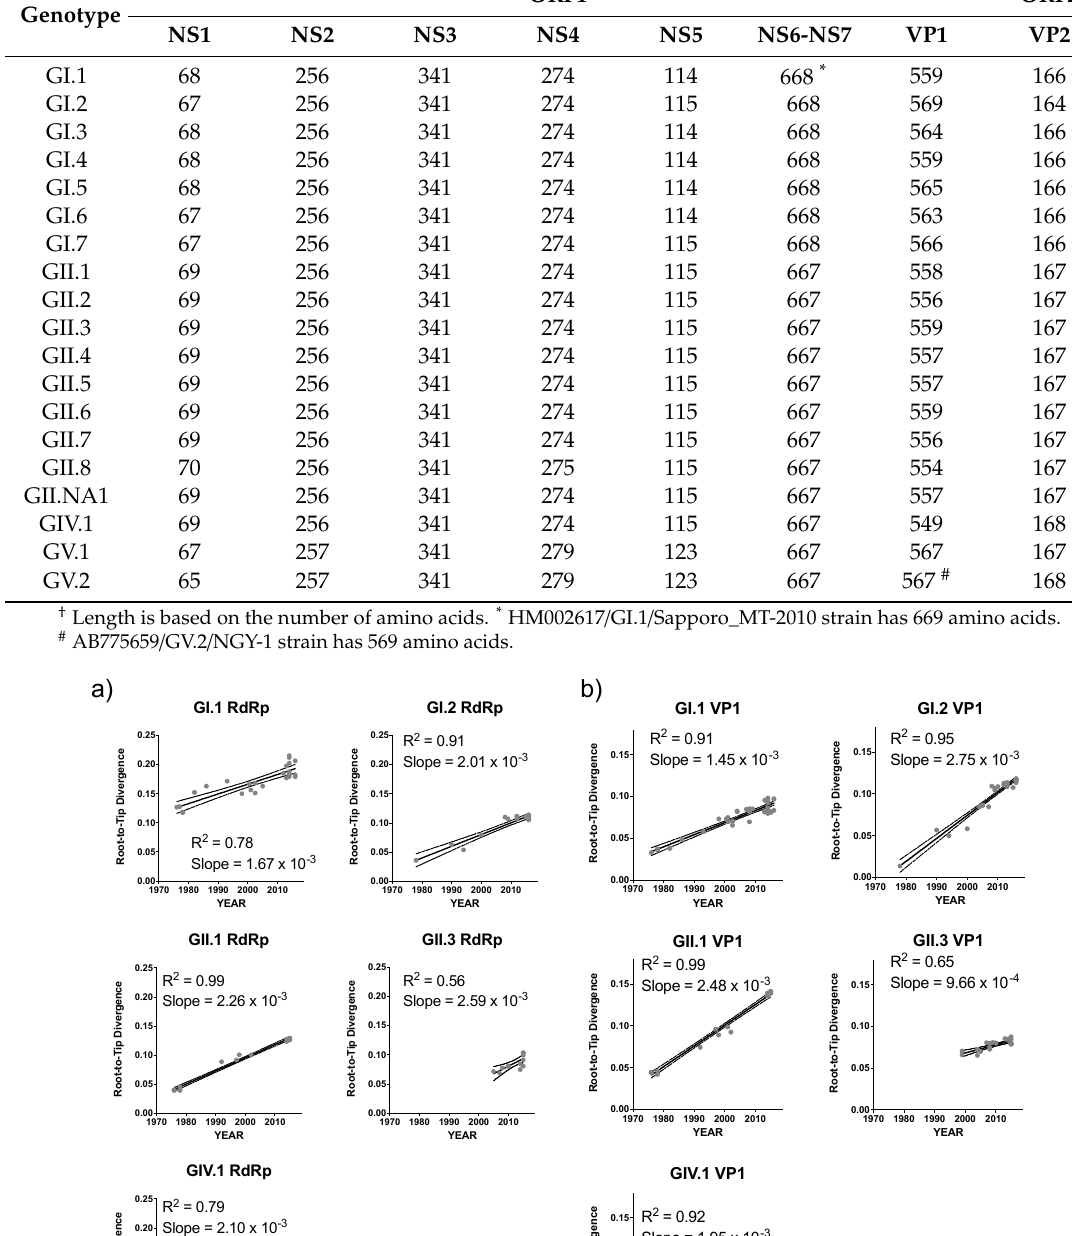
Table 3. Length of nonstructural and structural proteins † .